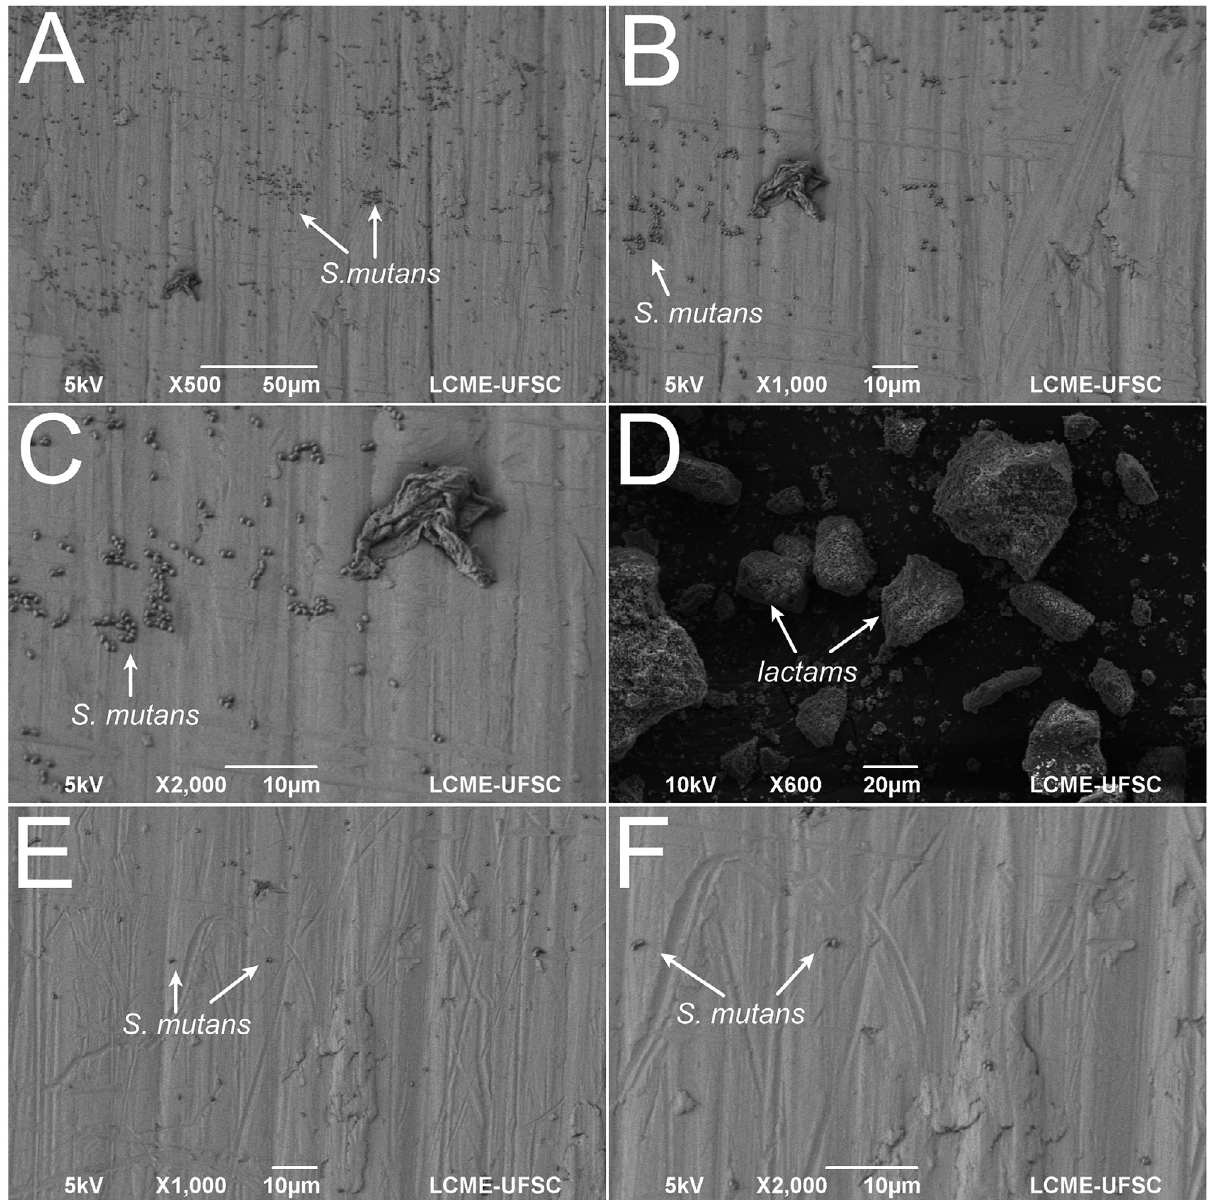
Figure 6- Scanning electron microscopy images of (A-C) Streptococcus mutans free of lactam effect, (D) lactam powder particle and (E-F) S. mutans in the presence of